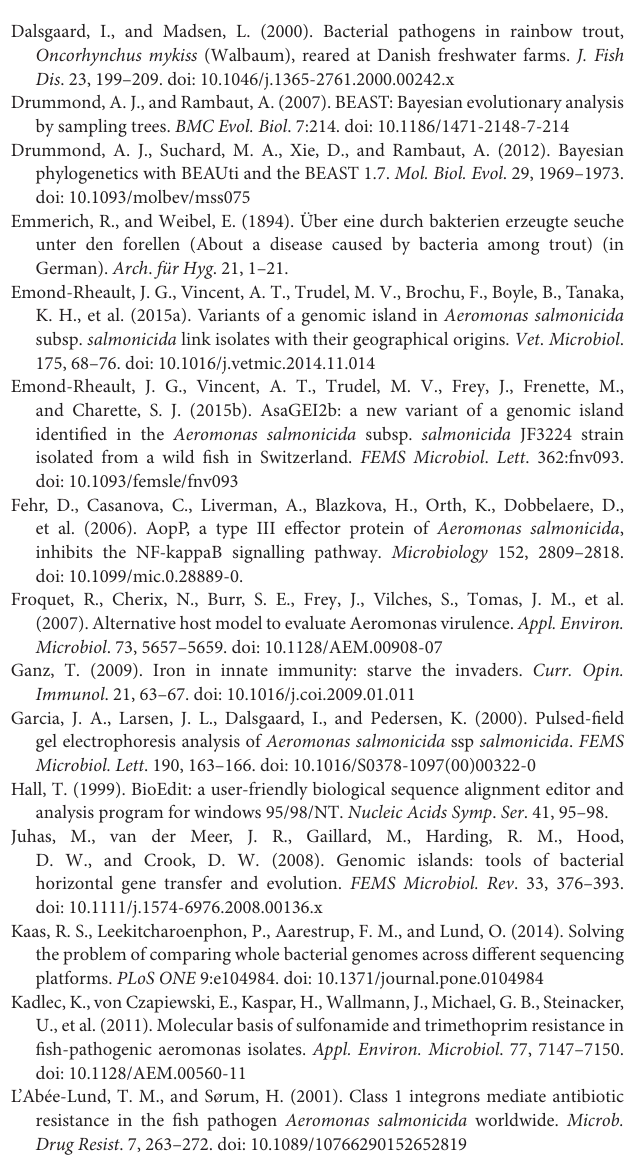
accession number. Isolates are labeled as stated in Figure 1 . Table S4 | Single Nucleotide Polymorphism (SNP) matrix of the 101 sequenced A. salmonicida subsp. salmonicida isolates and the reference A449. The matrix shows the SNP difference between each A. salmonicida subsp. salmonicida isolate, with 2 being the lowest and 215 being highest SNP difference among the isolates. Table S5 | Plasmid content of the 101 A. salmonicida subsp. salmonicida sequenced isolates and the reference A449. Numbers under each plasmid name represent percent coverage of that plasmid (in base pairs) for a given isolate. Except for plasmid pAsa6 and pAsa7, if percent coverage is higher than 60%, the plasmid is said to be indicated as present in the isolate and the color of the cell is green. Threshold limit for presence of plasmid in an isolate